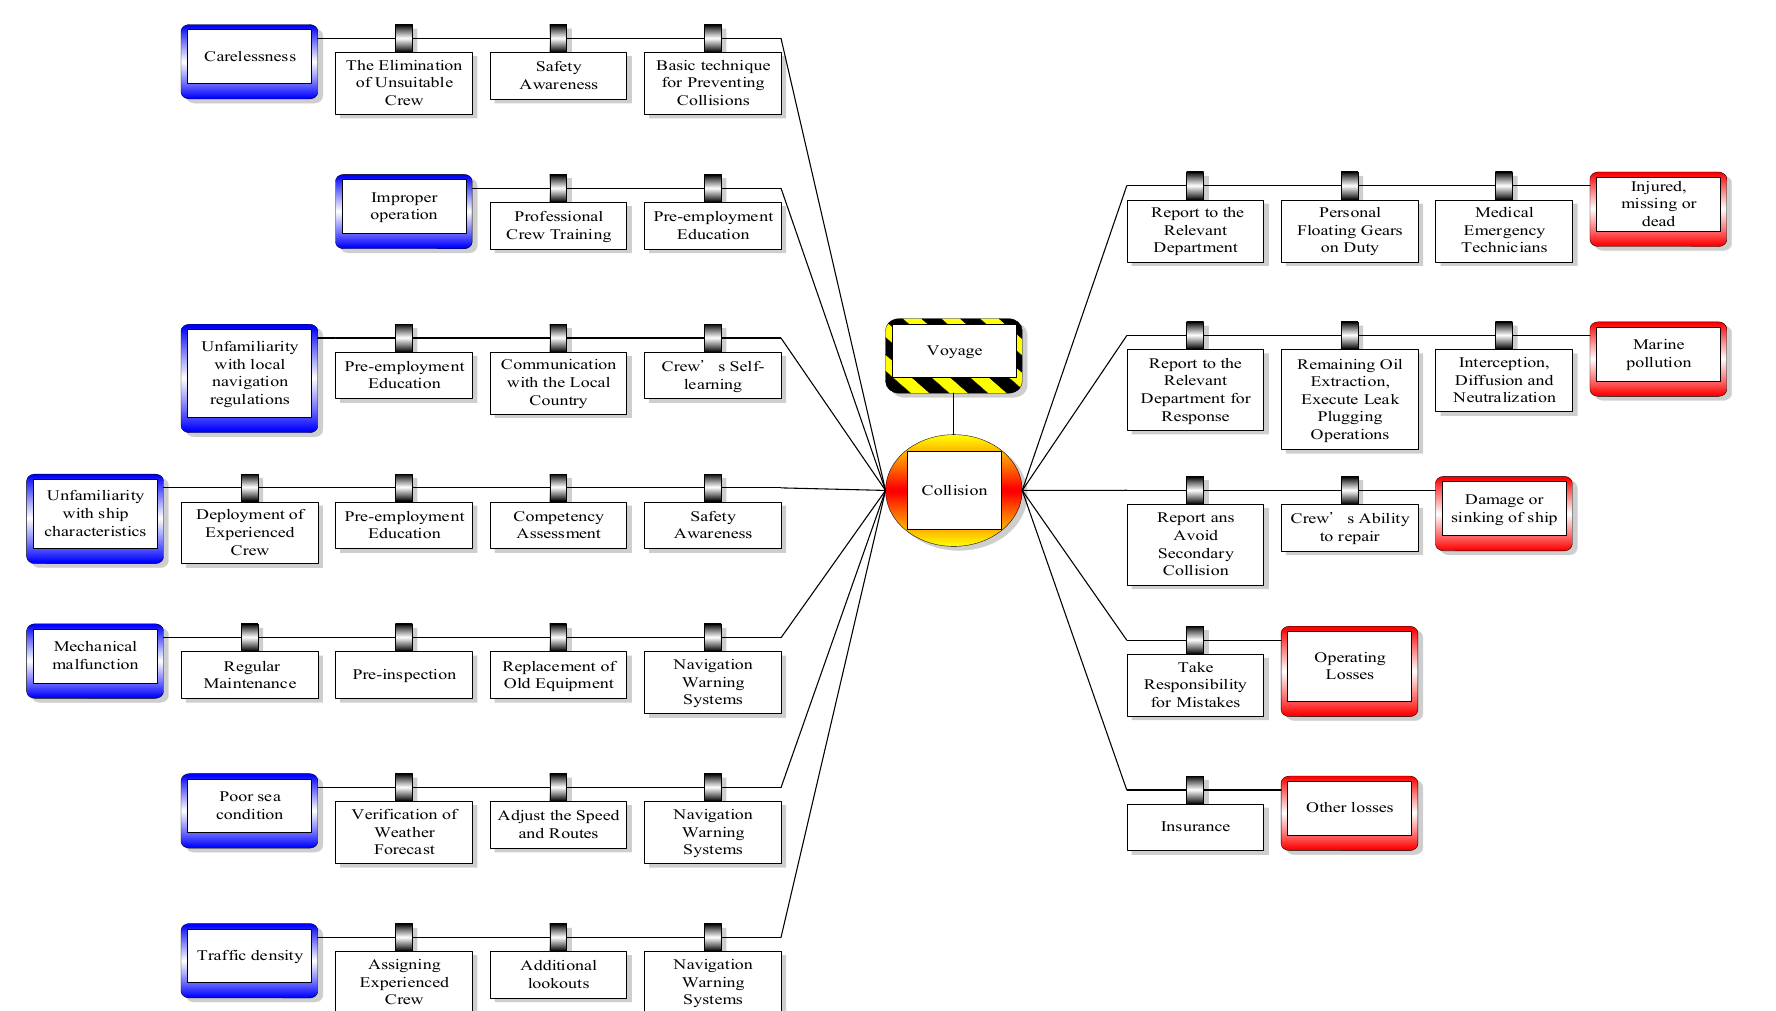
Figure 2. Bow-tie risk analysis diagram of ship collision incidents.